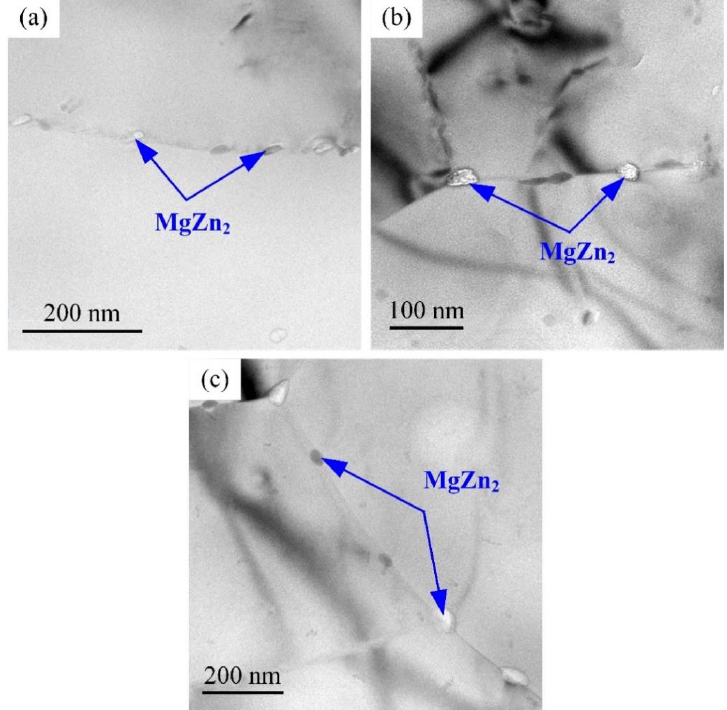
Figure 13. TEM images of grain boundary morphology in 7N01 aluminum alloy after different heat treatment conditions. ( a ) Base metal; ( b ) 300 °C and ( c ) 350 °C. treatment conditions. ( a ) Base metal; ( b ) 300 ◦ C and ( c ) 350 ◦